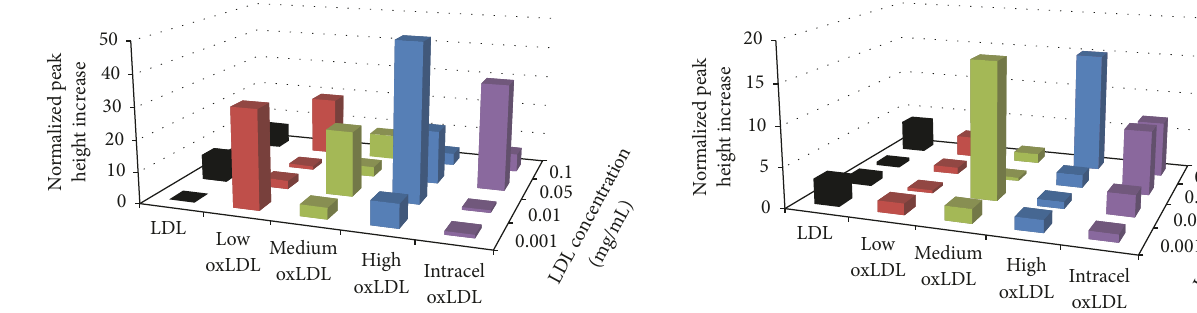
Figure 2: Average metabolic lactate production response of RAW 264.7 cells to a 6 min exposure of various LDL. Percent increases were calculated based on the variation from the maximum peak height chance during exposure to the baseline average, prior to exposure.FornativeLDL,thelactateproductionat100 𝜇 g/mL 𝑛 = 3 ; ± 0.01%, 50 𝜇 g/mL 𝑛 = 2 ; ± 0.005%, 10 𝜇 g/mL 𝑛 = 5 ; ± 0.35%, and 1 𝜇 g/mL 𝑛 = 4 ; ± 0.04%. For low oxLDL at 100 𝜇 g/ml 𝑛 = 4 ; ± 0.6%, 50 𝜇 g/ml 𝑛 = 4 ; ± 0.12%, 10 𝜇 g/ml 𝑛 = 5 ; ± 0.14%, and 1 𝜇 g/ml 𝑛 = 4 ; ± 0.02%. For medium oxLDL at 100 𝜇 g/ml 𝑛 = 4 ; ± 0.47%, 50 𝜇 g/mL 𝑛 = 4 ; ± 4.6%, 10 𝜇 g/mL 𝑛 = 4 ; ± 0.26%, and 1 𝜇 g/mL 𝑛 = 5 ; ± 0.25%. For high oxLDL at 100 𝜇 g/mL 𝑛 = 3 ; ± 0.67%, 50 𝜇 g/mL 𝑛 = 5 ; ± 0.26%, 10 𝜇 g/mL 𝑛 = 3 ; ± 0.12%, and 1 𝜇 g/mL 𝑛 = 4 ; ± 0.9%. For Intracel oxLDL at 100 𝜇 g/mL 𝑛 = 5 ; ± 0.03%, 50 𝜇 g/mL 𝑛 = 4 ; ±